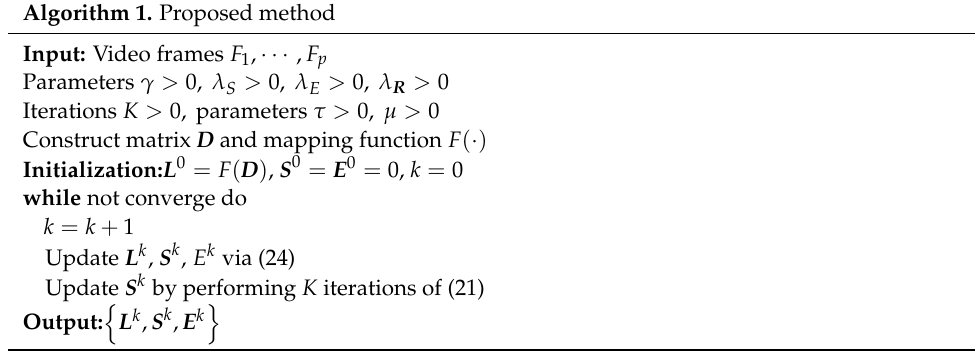
Algorithm 1. Proposed